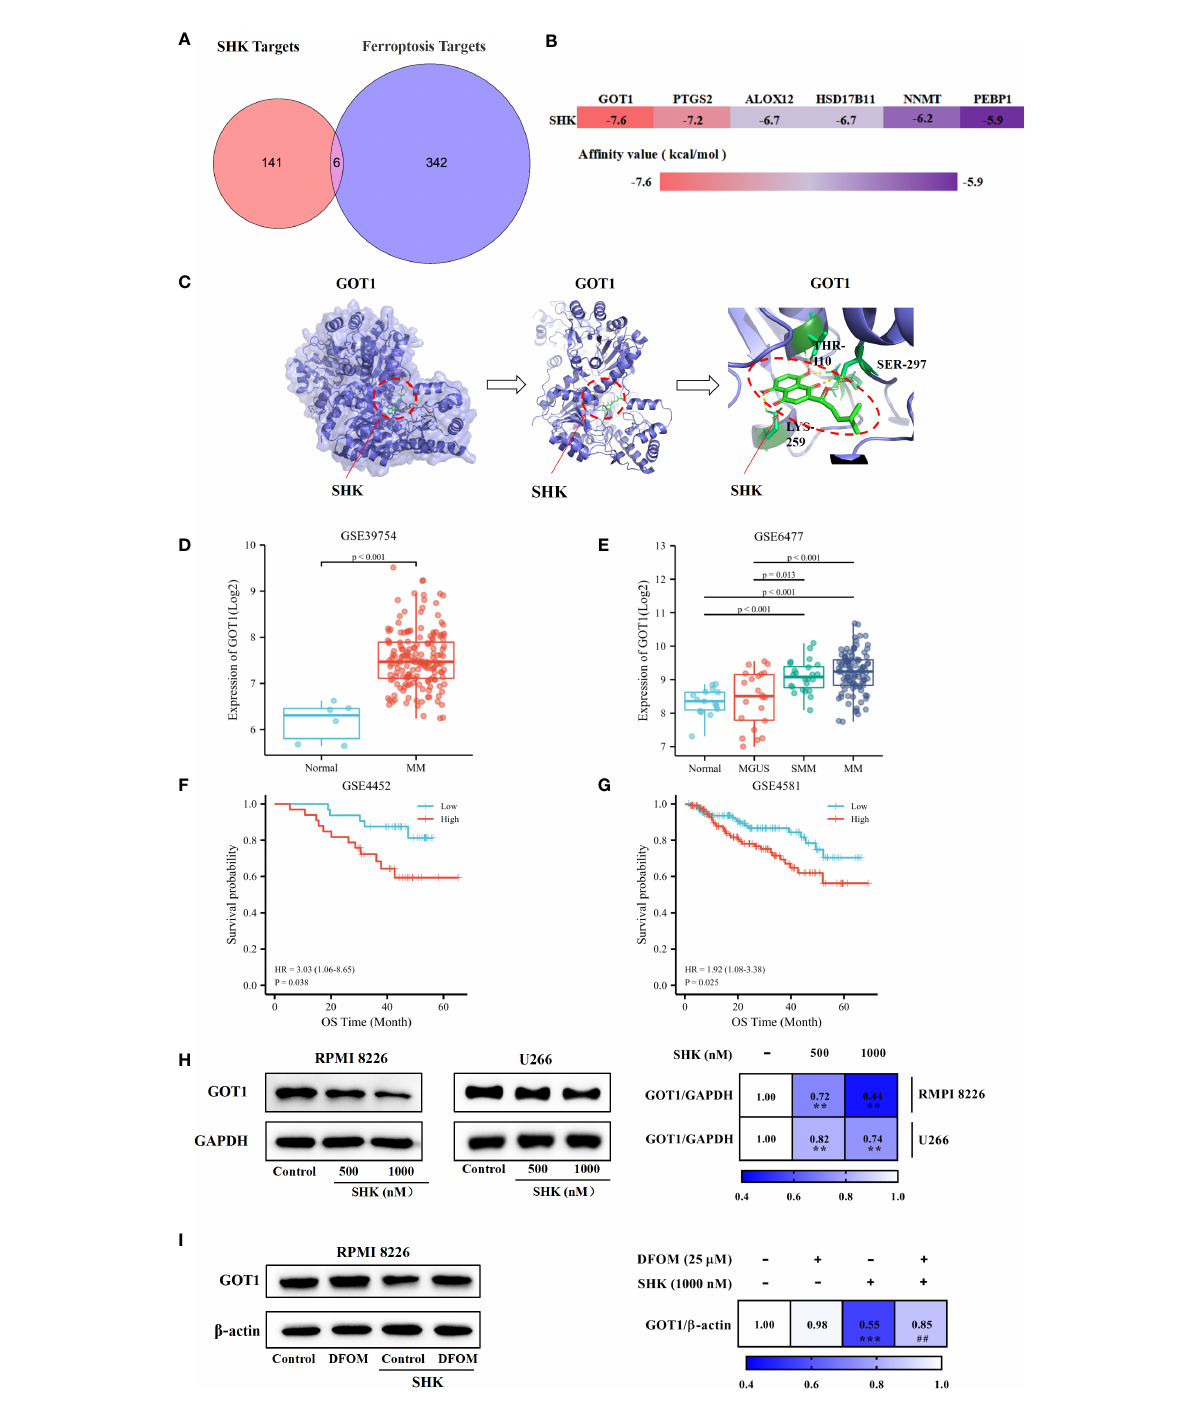
FIGURE 4 GOT1 inhibition contributes to SHK-induced ferroptosis in MM. (A) Common targets of SHK and ferroptosis. (B) The binding energy of SHK bind with potential targets. (C) Molecular docking between SHK and GOT1. (D) The comparative study of GOT1 expression between healthy people and MM patients in GSE39754 database. (E) The comparative study GOT1 expression among healthy people and MGUS, SMM and MM patients in GSE6477 database. (F, G) The K-M survival curves analysis of GSE4452 and GSE4581 databases. (H) The expression of GOT1 in fl uenced by SHK treatment for 24 h in RPMI 8226 and U266 cell lines. (I) The effects of DFOM on SHK regulated GOT1 expression. **p < 0.01, ***p < 0.001, ##p <